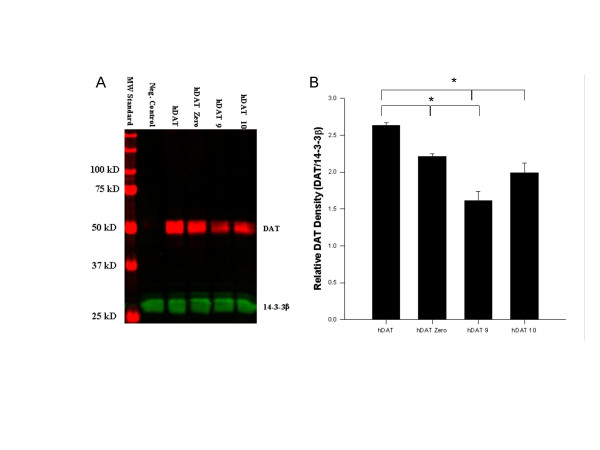
Results of western analysis support the rank order of DAT density observed in saturation binding experiments. A) Lane 1: molecular weight marker, Lane 2: negative control, Lane 3: hDAT transfected cell line, Lane 4: hDAT Zero transfected cell line, Lane 5: hDAT 9 transfected cell line, Lane 6: hDAT 10 transfected cell line. Blots were probed both with a rat anti-DAT monoclonal antibody specific for the transporter's N-terminal region as well as a 14-3-3β polyclonal antibody to control for possible protein loading differences. DAT immunoreactivity was detected with an Alexa Fluor 680 conjugated anti-rat IgG (red) and 14-3-3β immunoreactivity with an IRDye-800 conjugated anti-rabbit IgG (green). B) DAT immunoreactivity was normalized to the 14-3-3β signal, densiometrically quantified with respect 14-3-3β content, and analyzed via a one way ANOVA with a Holm-Sidak post-hoc analysis. Statistically significant differences (* = p < 0.05) were detected for all comparisons except the hDAT10-vs-hDAT Zero comparison.